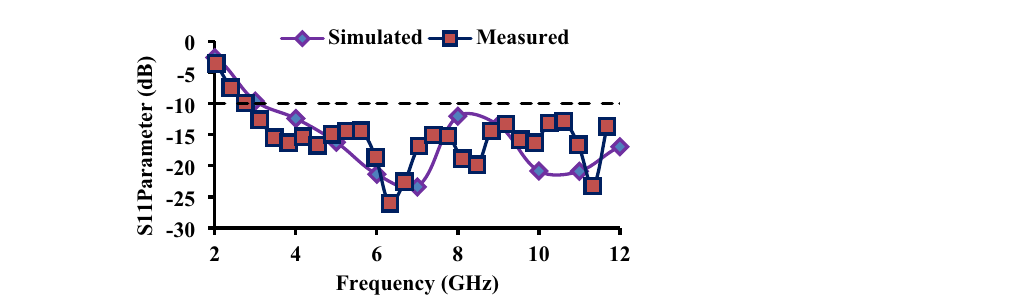
Figure 10. Measured and simulated S 11 of the proposed antenna.